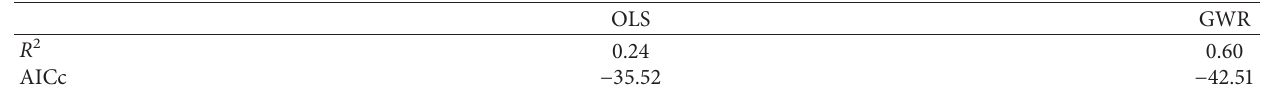
Table 5: Comparison of OLS regression and GWR regression